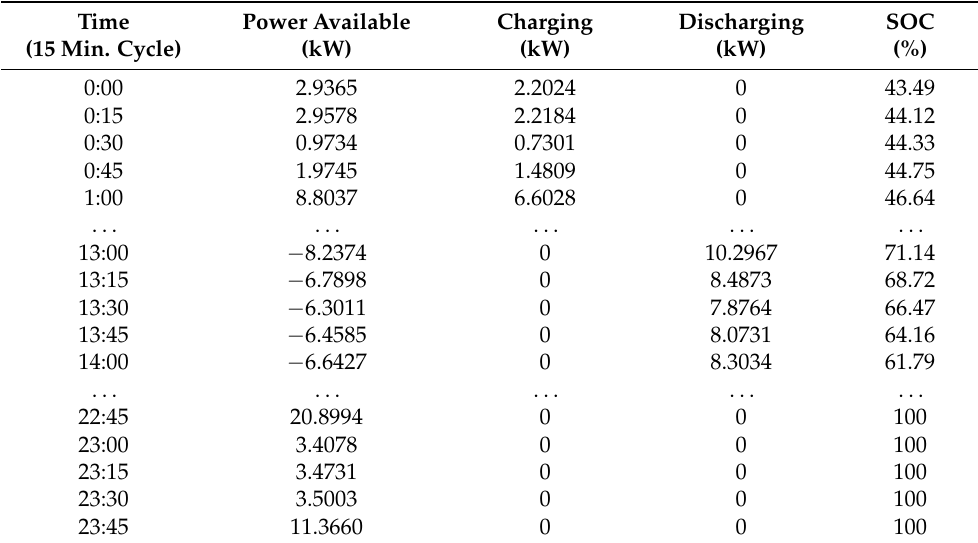
Figure 13. State of charge of Street Battery in Normal Grid. Table 7. Power available, Charging, Discharging and SOC in Faulty